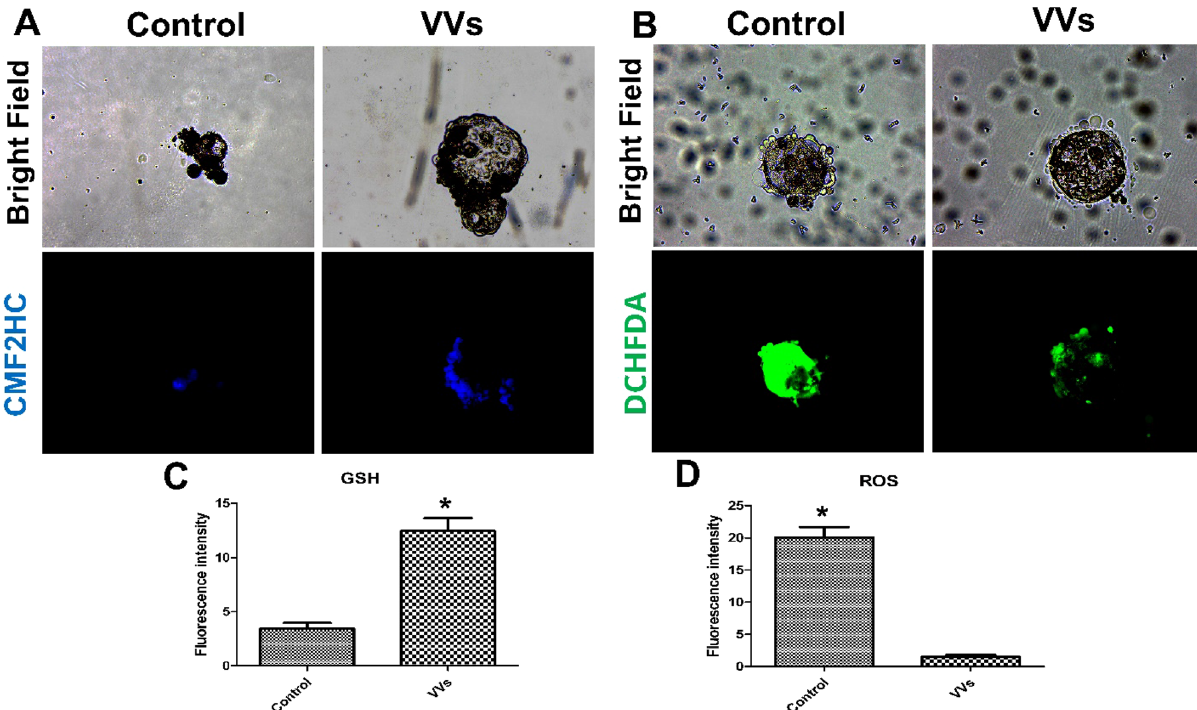
Figure 7. Effect of VVs on antioxidative status of embryos. ( A ) Reduced glutathione (GSH) was detected with CMF2HC stain and expressed as blue fluorescence, while reactive oxygen species (ROS) were stained with H2DCFDA and expressed as green fluorescence ( B ). ( C and D ) graphs show the comparison between the fluorescence intensity and values (mean ± SD) compared with Student’s t-test. Values denoted by an asterisk (*) were considered statistically different ( p < 0.05).